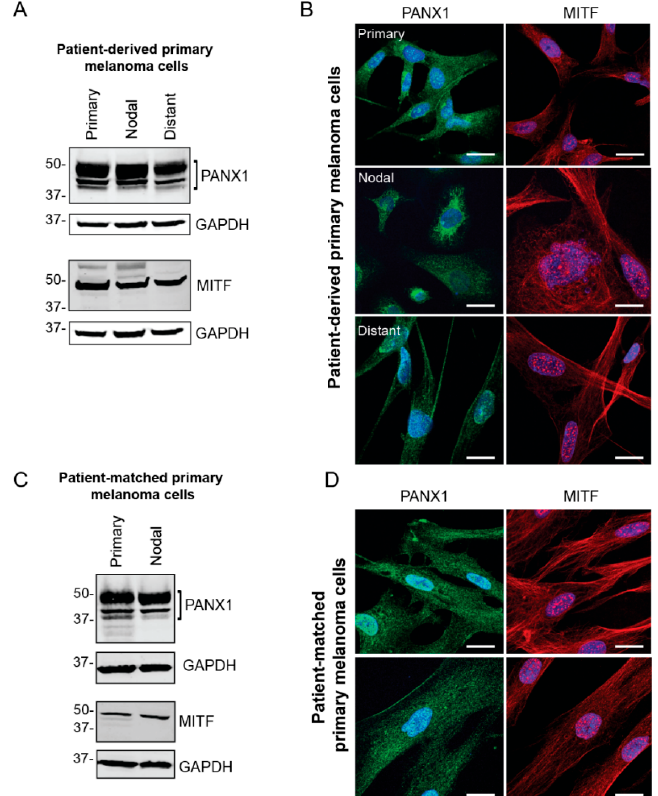
Figure 2. PANX1 is highly expressed in patient-derived primary melanoma cells. ( A ) Representative PANX1 levels in primary cells derived from melanoma biopsies of patient tumors with primary (N =